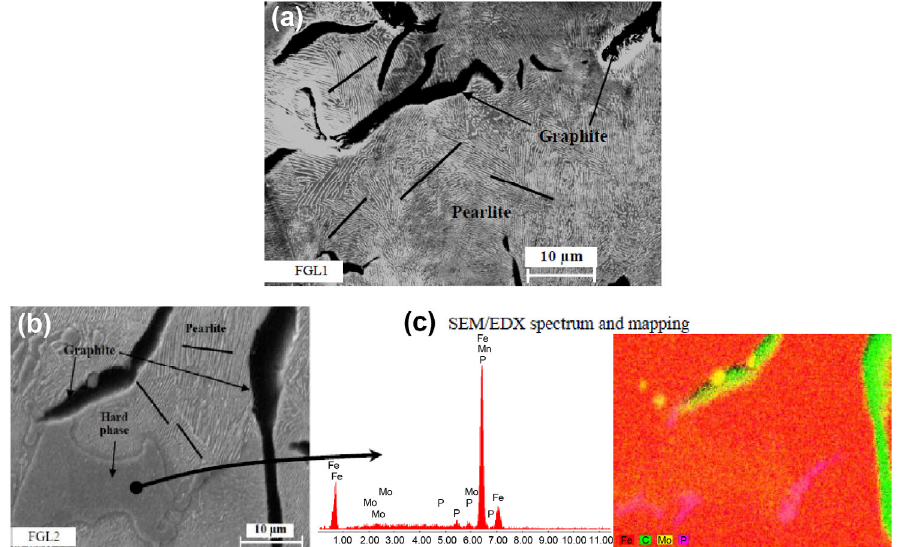
Fig. 1 Microstructures of the studied grey cast irons: (a) classical lamellar iron FGL1, (b) microalloyed lamellar iron FGL2, and (c) SEM/EDX spectrum and mapping at the hard phase